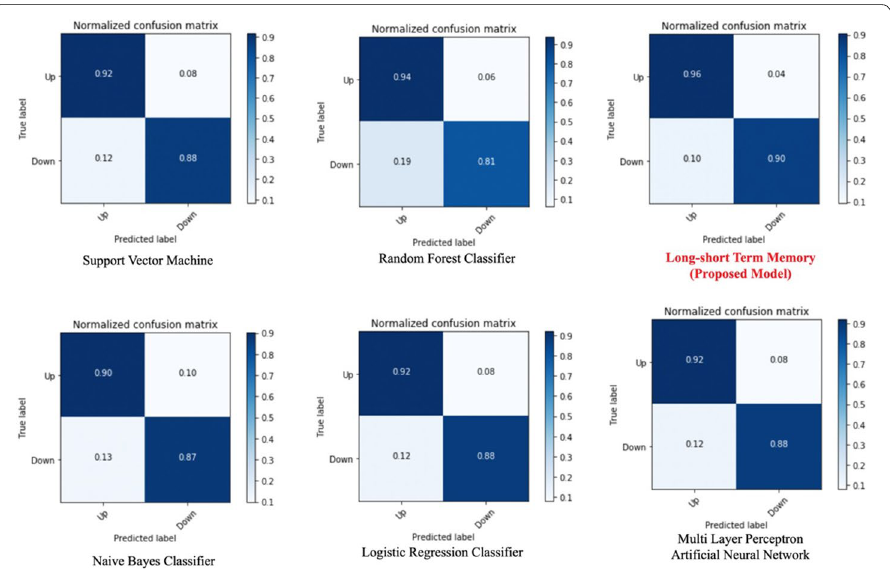
Fig. 9 Model prediction comparison—confusion